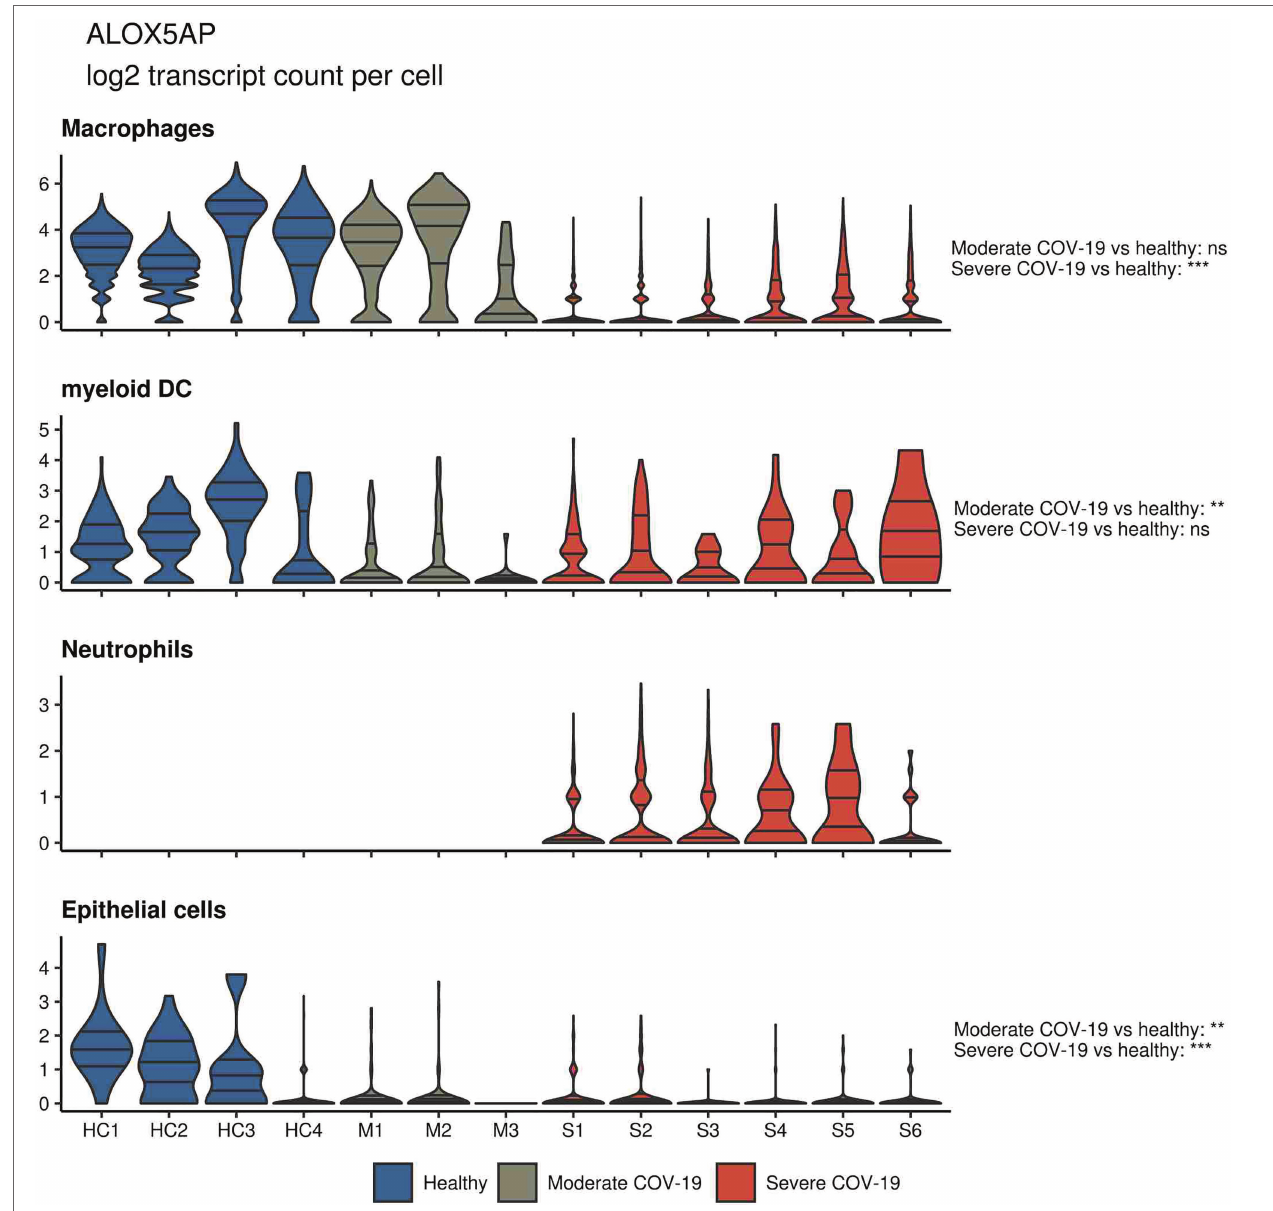
FIGURE 3 | ALOX5AP expression in BALF cells from patients affected by COVID-19. Violin plots depicting ALOX5AP expression levels within specific cellular populations in BALF cells from healthy (blue, n = 4), moderate (gray, n = 3), or severe (red, n = 6) COVID-19 patients. RNA sequencing data are publicly available (Liao et al., 2020). ns = non-significant, ** p < 0.01, *** p <